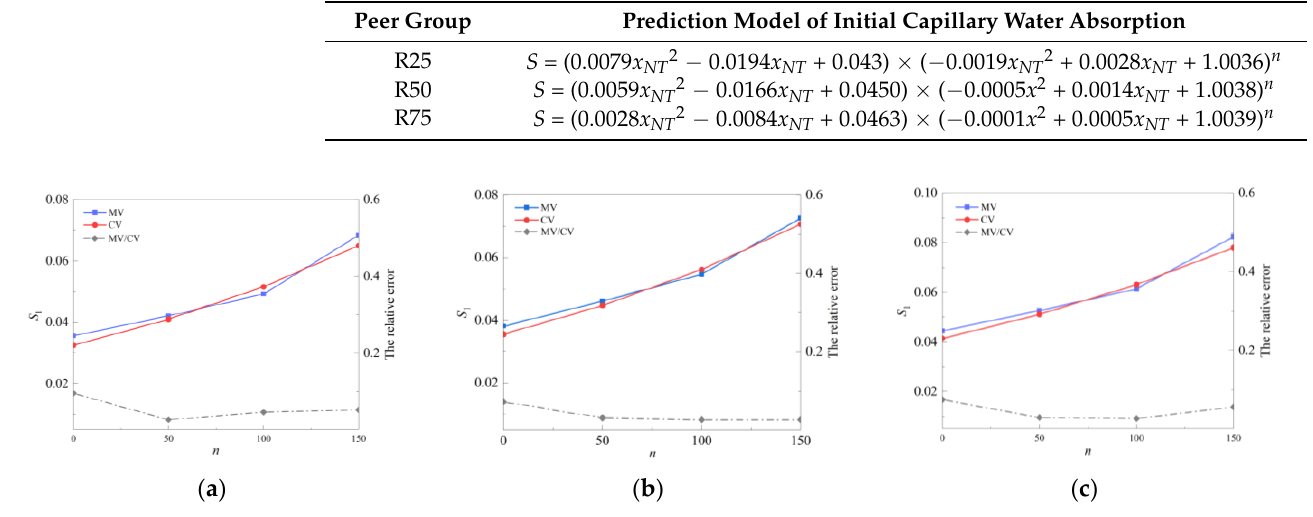
Figure 12. Relationship between measured and calculated values of the prediction model. ( a ) R25 group; ( b ) R50 group; ( c ) R75 group.